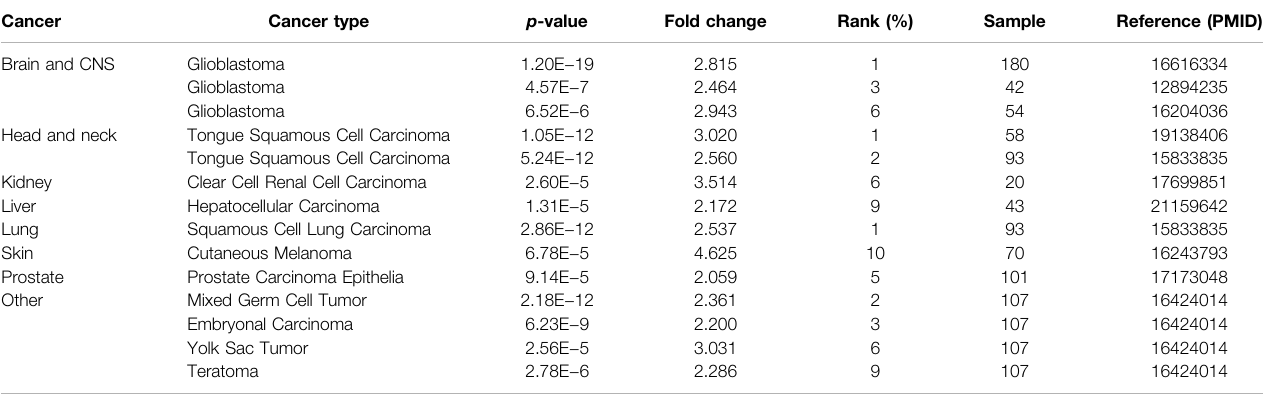
TABLE 1 | SHC1 expression in cancers verus normal tissue in Oncomine